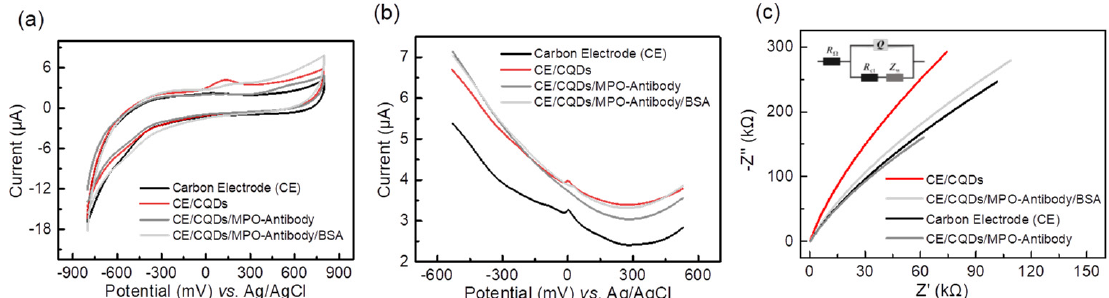
Figure 4. Electrochemical characterizations of the CQD-modified electrode as the MPO sensor. ( a ) CV and ( b ) DPV characterizations of bare carbon electrode (CE), CE/CQDs, CE/CQDs/Antibody, and CE/CQDs/Antibody/BSA in the presence of 1 × PBS. ( c ) The equivalent circuit model of chemically modified electrode and the EIS-fitted curves.